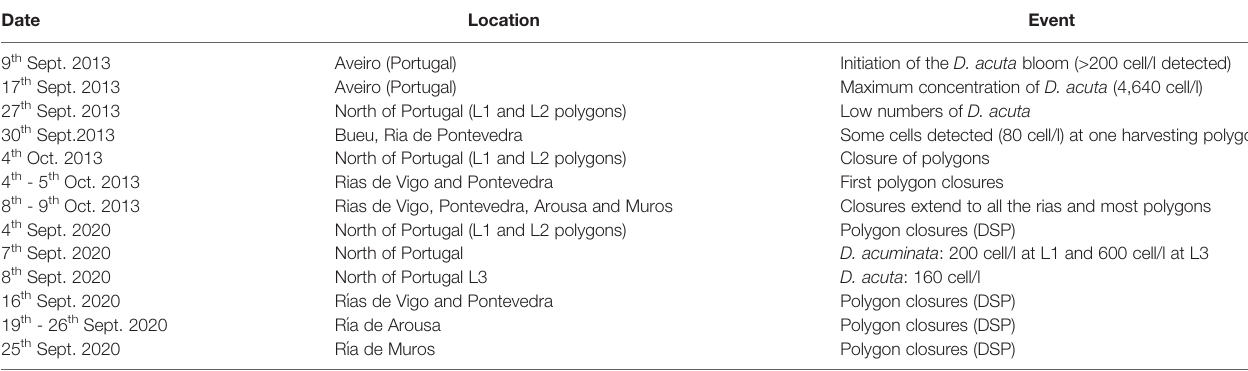
Data from the INTECMAR and IPMA Galician and Portuguese HAB